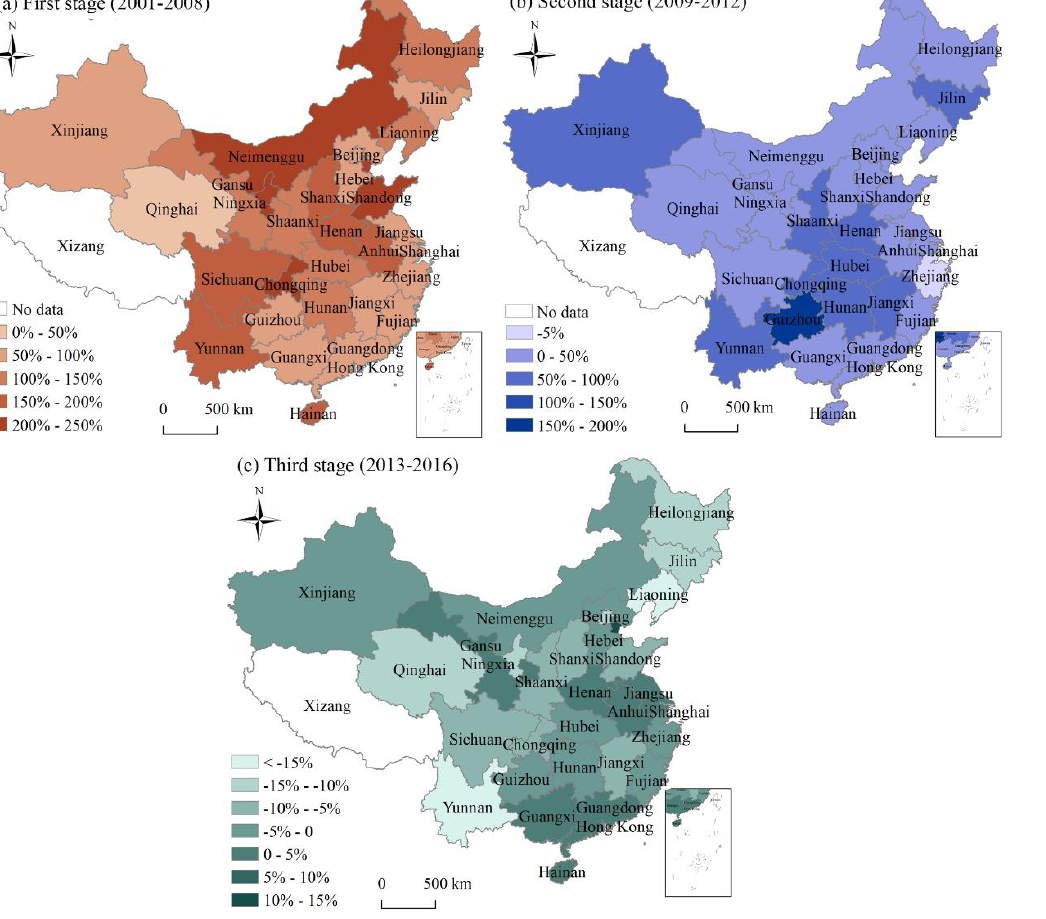
Figure 6. Average growth index of land finance of the thirty provinces in stage one, two, and three (primary axis (left) for the first stage and second stage, secondary axis (right) for the third stage).